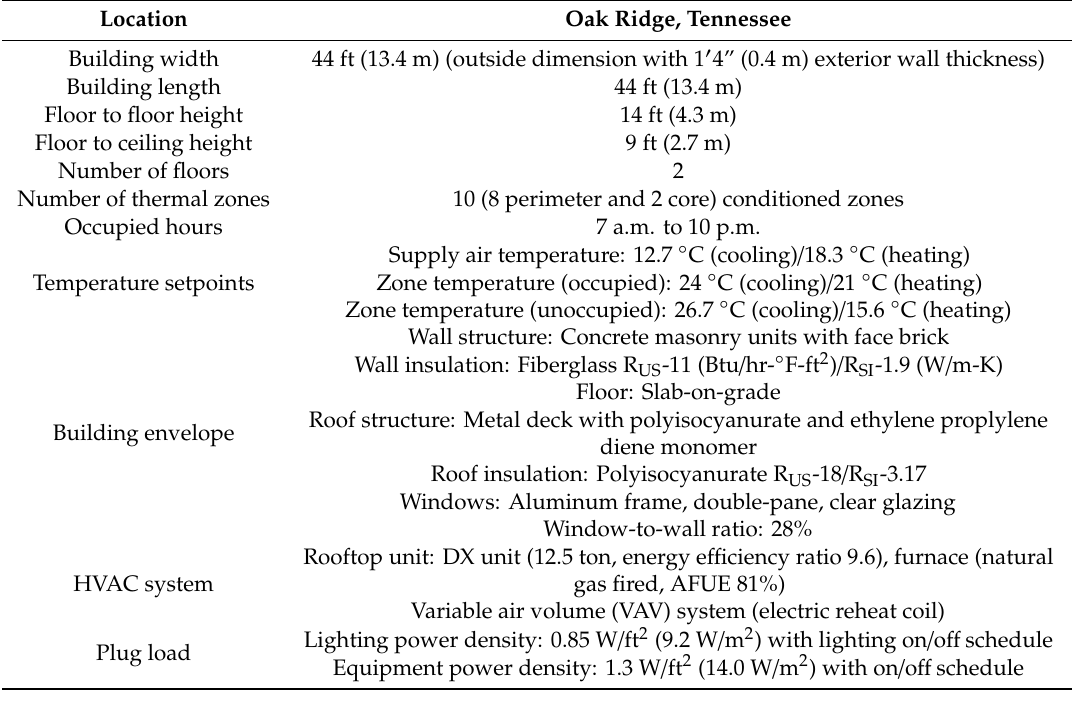
Table 1. Flexible research platform general